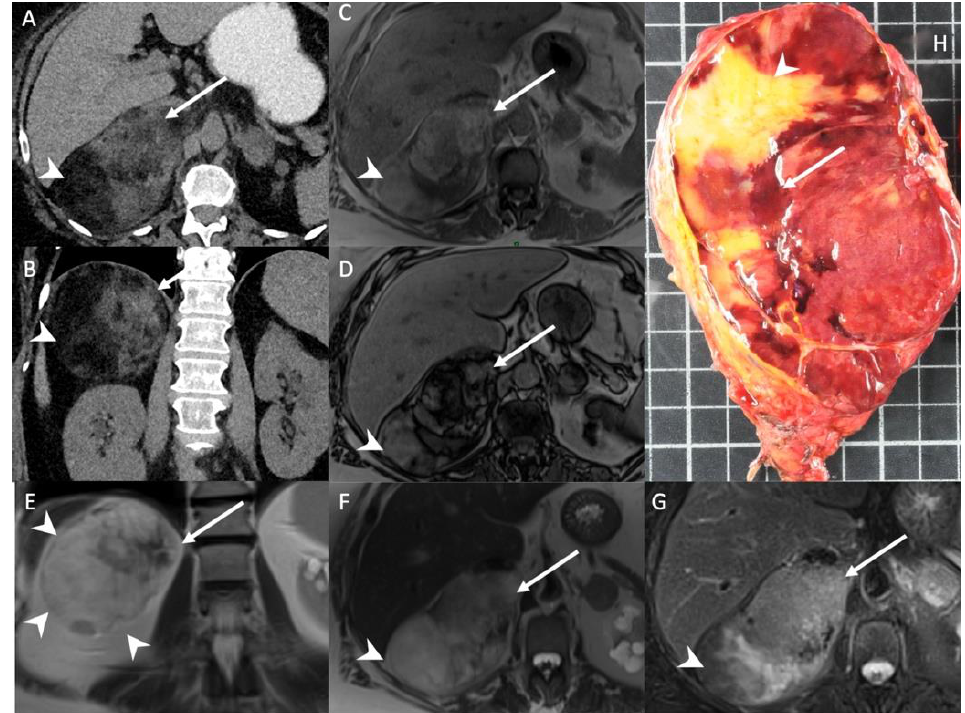
Figure 1. A 56-year-old woman with right adrenal incidentaloma. Unenhanced CT images in the axial ( A ) and coronal ( B ) planes show a 12-cm, well limited and encapsulated adrenal lesion, with low-attenuation ( −7 0 HU) areas consistent with macroscopic fat content (arrow- heads) and high-attenuation (30 HU) areas (arrows) consistent with hematopoietic tissue. T1- weighted in-phase ( C ) and out-of-phase ( D ) images in the axial plane show the area with heterogeneous signal drop (arrow) in the out-of-phase image. Of note, no signal drop is seen in the areas containing macroscopic fat (arrowhead). T2-weighted images in the coronal ( E ) and axial ( F ) planes show internal macroscopic fat (arrowheads) with a signal intensity sim- ilar to that of retroperitoneal fat, whereas the hematopoietic tissue (arrow) is hypointense. ( G ) The fat-suppressed T2-weighted image in the axial plane shows a drop in signal intensity in the macroscopic fat portion (arrowhead) by comparison with the signal intensity in ( F ), but not in the hematopoietic tissue (arrow). ( H ) Photograph showing gross specimen after right adrenalectomy. Pathologic analysis confirmed a well-encapsulated myelolipoma con- taining both red hematopoietic tissue (arrow) and yellow macroscopic fat (arrowhead). Each square in the background has a side of 1 cm.